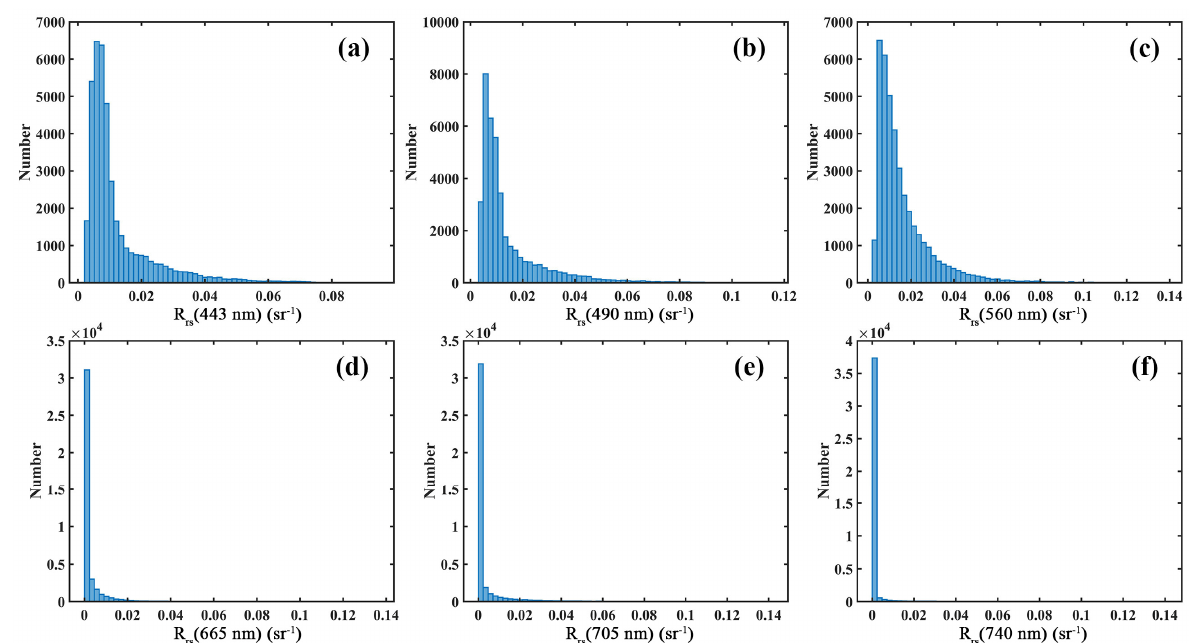
Figure 4. The distribution histogram of the generated R rs ( λ ) (sr − 1 ) for each wavelength from 443 nm to 740 nm, ( a ) 443 nm; ( b ) 490 nm; ( c ) 560 nm; ( d ) 665 nm; ( e ) 705 nm; ( f ) 740 nm.